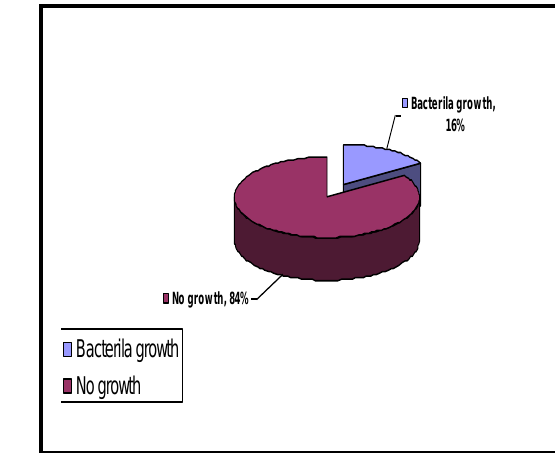
Figure 2. Bacterial colonization rates of bar soaps